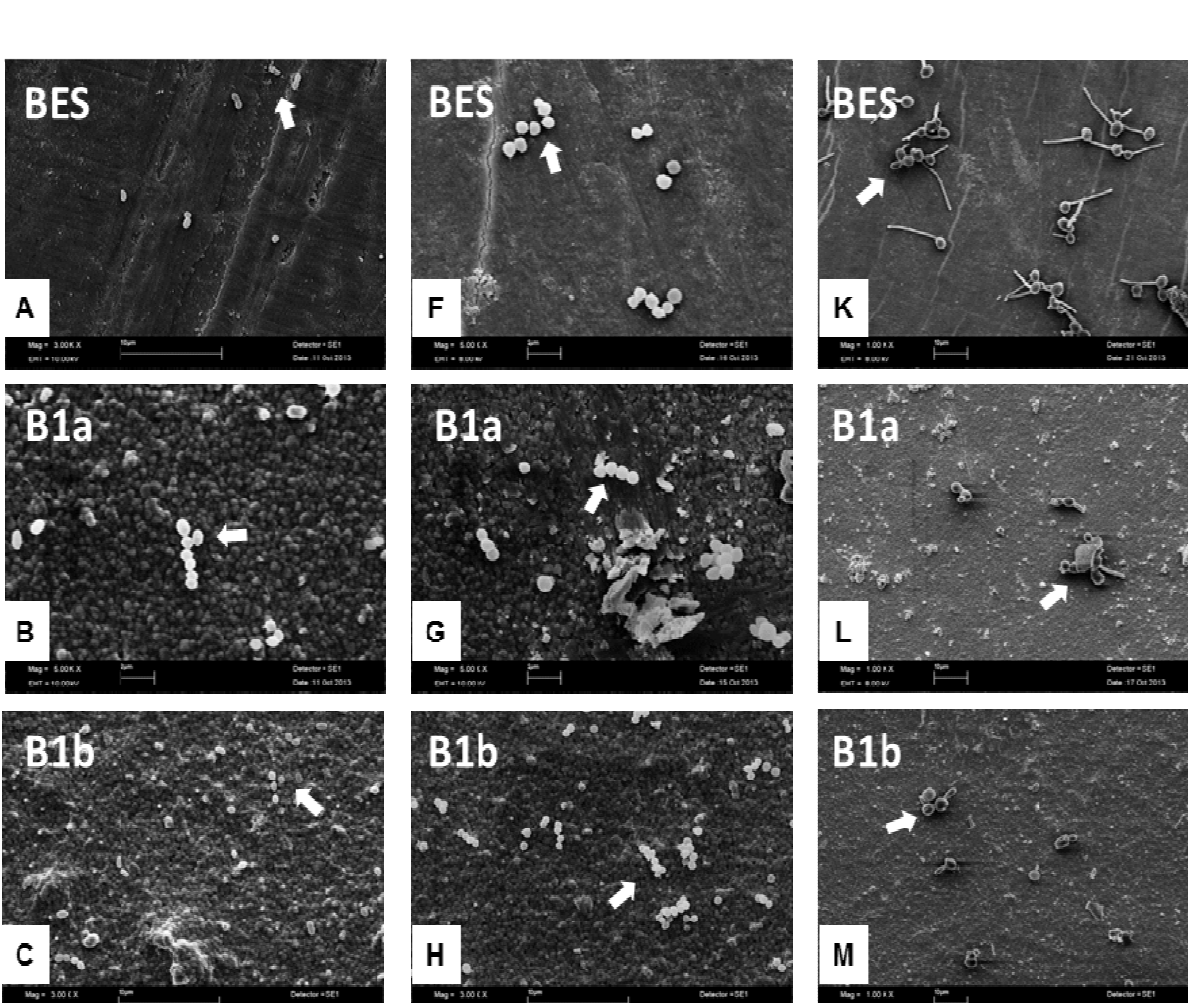
B1a: 3 mol% yttria-stabilized tetragonal zirconia polycrystal surface; B2a: B1a with zirconium oxide (ZrO ) coating; B1b: B1a with zirconia-based composite coating; 2